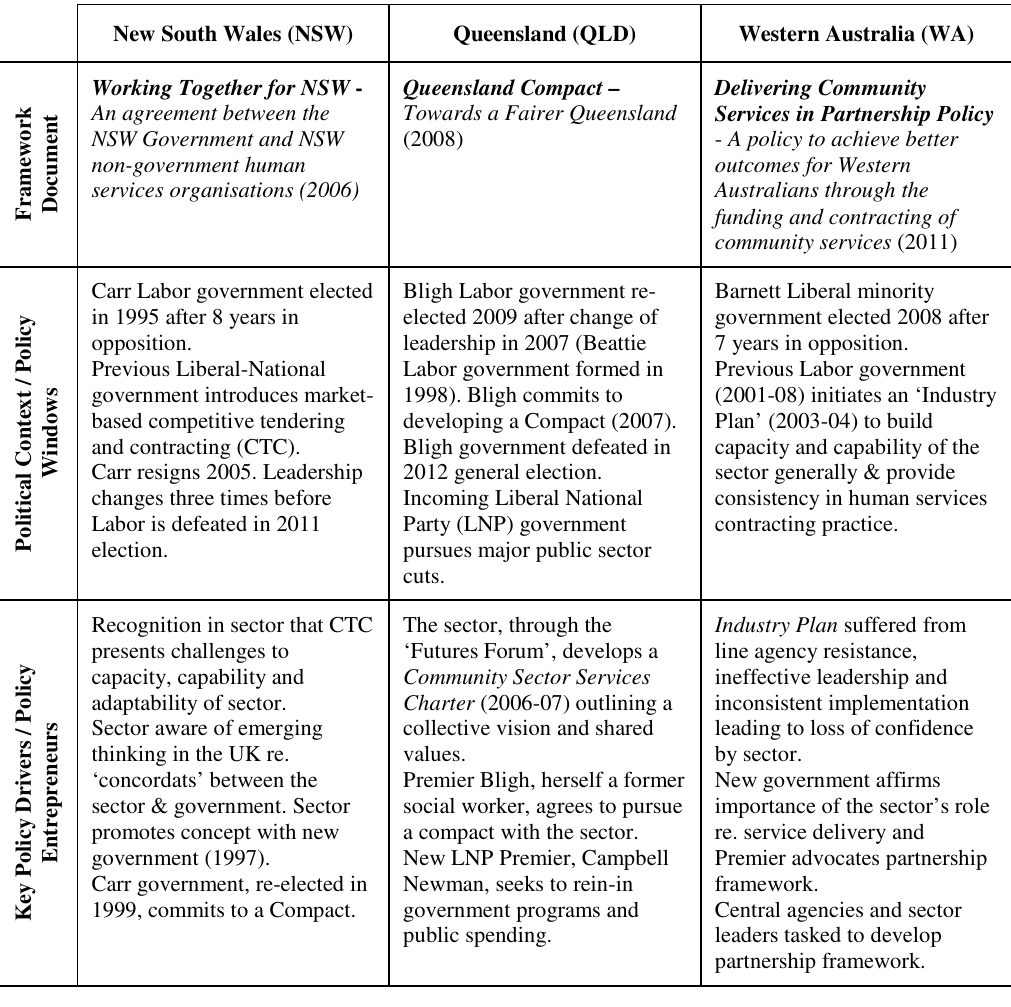
Table 2 — A Comparison of Frameworks for Inter-sectoral Cooperation in Selected Australian States: Political Context & Key